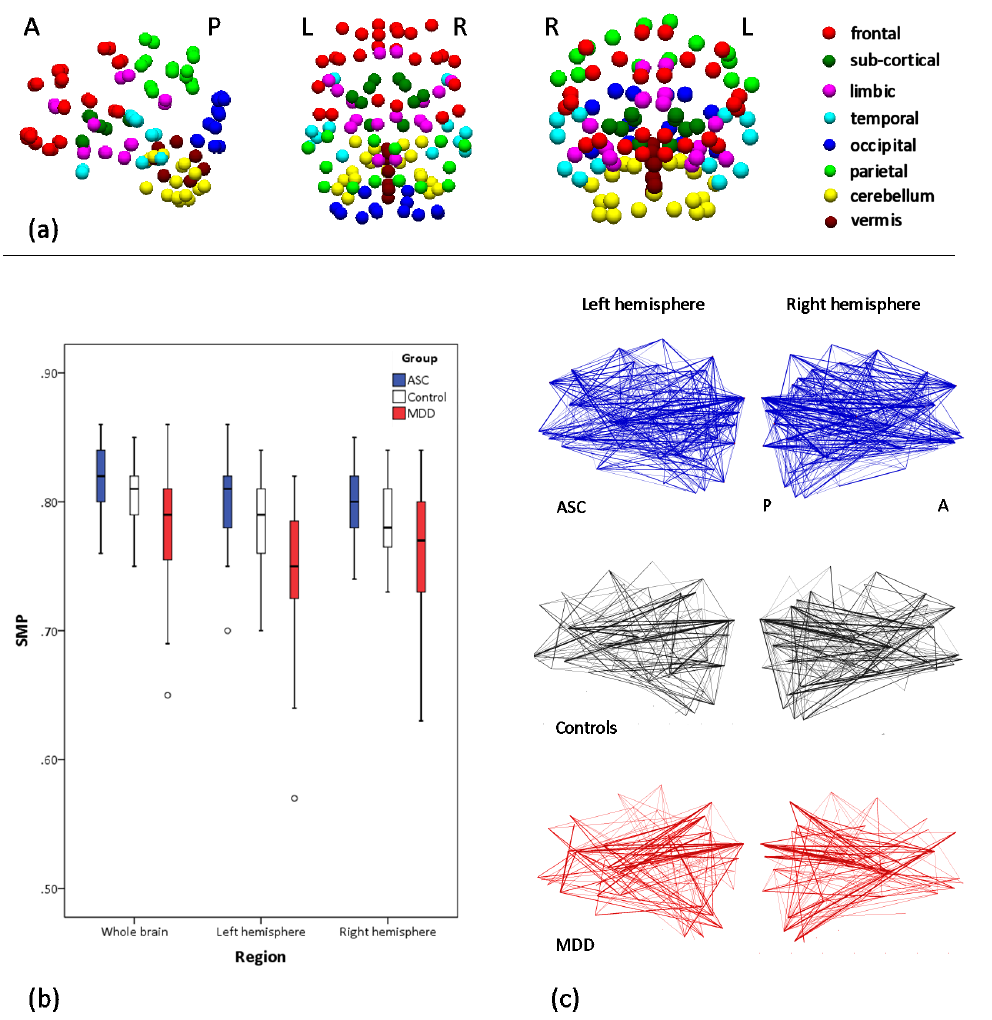
Fig 2. Semi-metric percentages and backbones. (a) Sagittal, axial and coronal projections of nodes coloured according to the modules in which they are contained. (b) Between-group comparisons (patient groups relative to controls) for whole brain, left and right hemisphere SMP displayed as box-and-whisker plots identifying the median by the central line, the 25 th and 75 th percentile ranges by the limits of the box, and the minimum and maximum range (excluding outliers) by the limits of the whiskers. Outliers are individually displayed and defined as values > 1.5 the interquartile range from the 25% and 75% quartiles. (c) Sagittal projections of the left and right hemispheres of the semi-metric backbones for each group. The thickness of the edges represents the percentage of participants within each group with a semi-metric edge at that location, with percentages > 90%